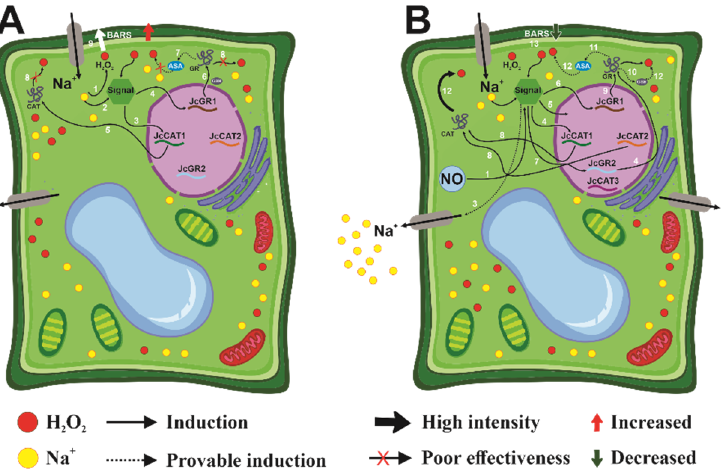
Figure 4. Model proposed for responses to salt stress. ( A ) Upon salt stress exposure, (1) the accumulation of sodium (Na + —yellow circles) inside the cells promotes an increase in hydrogen peroxide (H 2 O 2 —red circles) content. In parallel, (2) a still-unknown signaling pathway recognizes the H 2 O 2 and Na + accumulation and triggers an upregulation of (3) JcCAT1 and (4) JcGR1 gene expression, resulting in improved (5) catalase (CAT) and (6) glutathione reductase (GR) activities, respectively. The enhanced GR activity is caused by a greater (7) ascorbate (ASA) content. Nonetheless, these responses are not effective (8) for H 2 O 2 scavenging, resulting in severe damage to (9) membrane lipids. ( B ) Yet, NO priming (1) quickly activates the signaling pathway, reprogramming the salt responses. First, (2) it recognizes Na + accumulation and seems to activate (3) the effective extrusion of Na + back into the medium. Secondly, it induces the upregulation of (4) JcCAT1 , (5) JcCAT2 , (6) JcGR1, and (7) JcGR2 gene transcripts, which better direct (8) CAT and (9) GR activity. At the same time, the GR increases the contents of (10) glutathione (GSH) and (11) ASA. Finally, (12) the H 2 O 2 is almost scavenged, (13) avoiding damage to membrane lipids in embryo axis cells and enhancing the salt tolerance of J. curcas seedlings. Modified from the work of Gadelha, Miranda